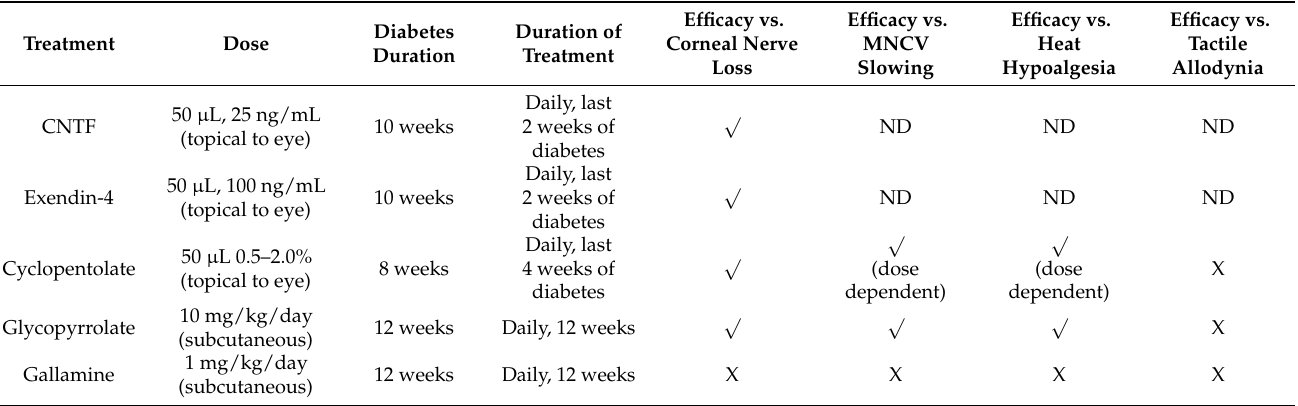
Table 2. Summary of treatments and their efficacy against indices of neuropathy in diabetic mice. ND = not determined.